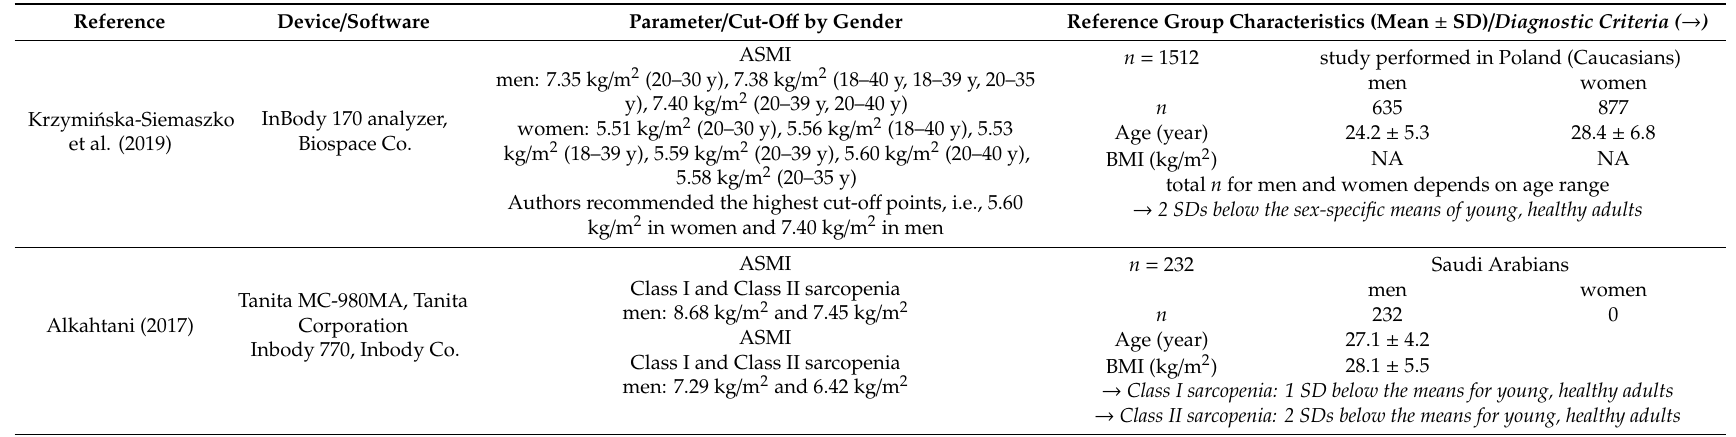
Table 2. Cut-o ff values and diagnostic criteria of a low muscle mass using bioelectrical impedance analysis